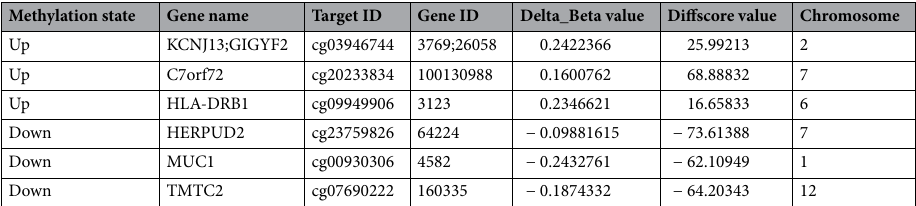
Table 1. Differential DNA methylation sites information between CD penetrating intestinal mucosal tissue with normal intestinal mucosal tissue.